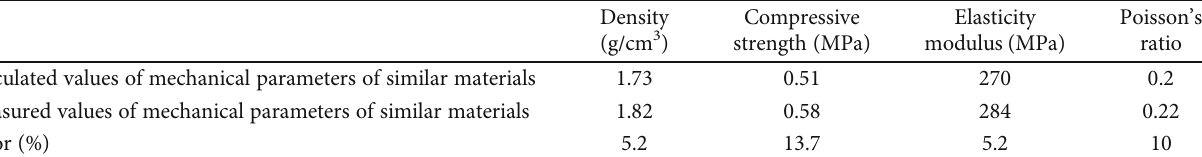
Table 8: Comparison between calculated and measured mechanical parameters of similar materials.